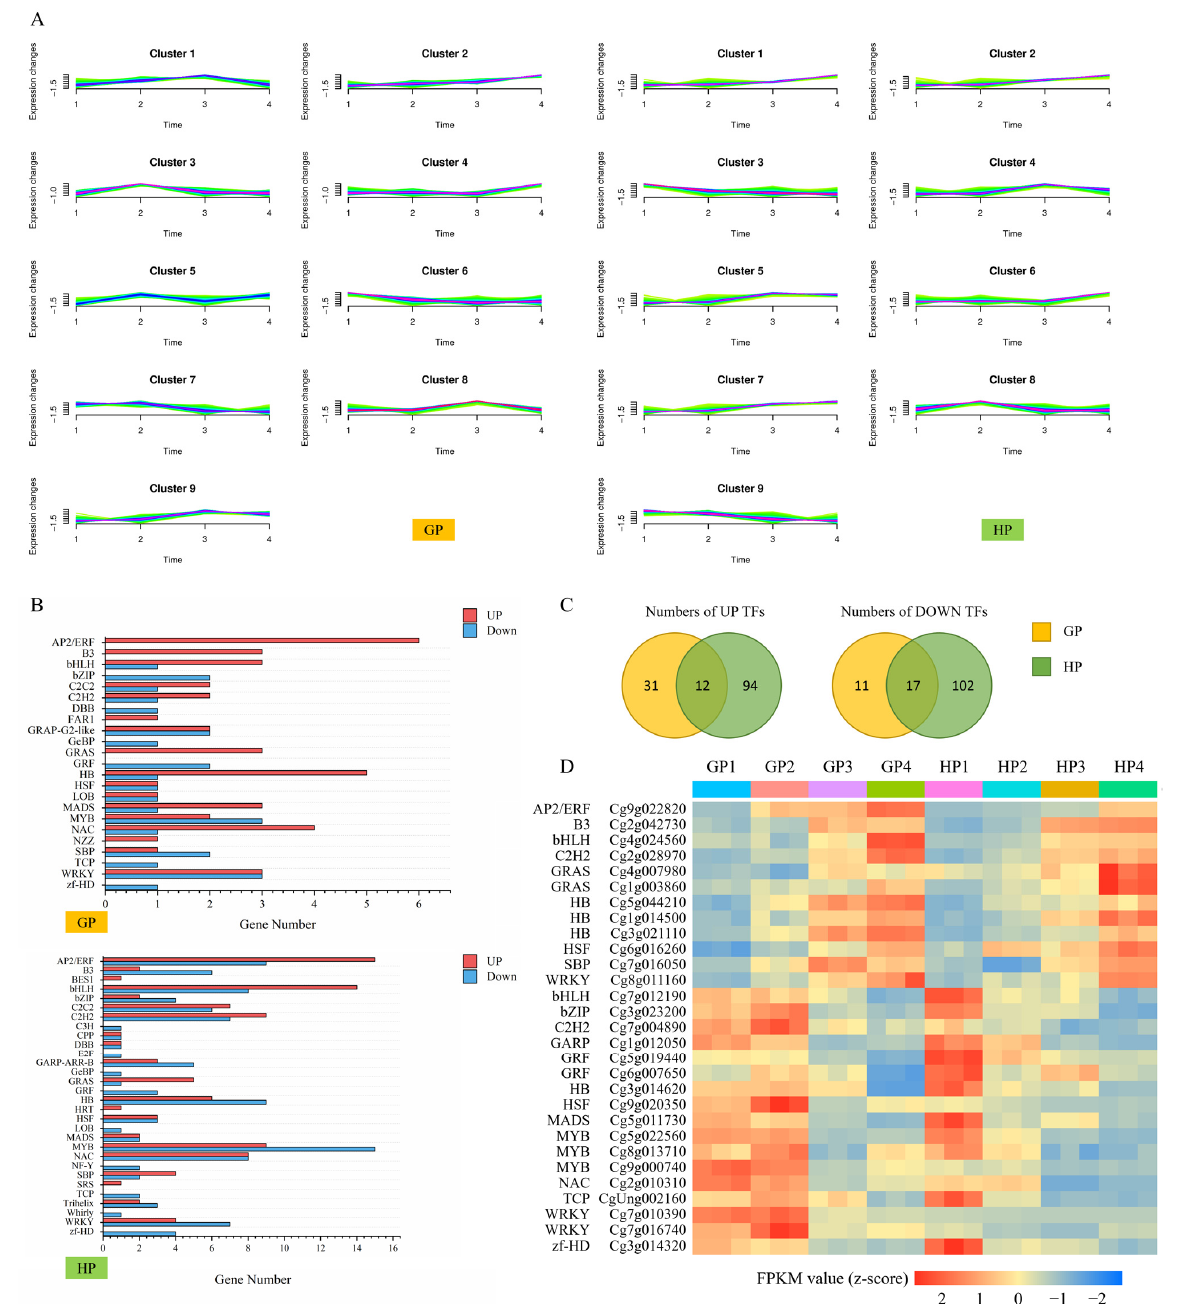
Figure 2. Screening of transcription factors (TFs). ( A ) Time cluster results in two varieties of young pomelo fruits. ( B ) TFs enrichments in specific clusters. In GP, clusters 2 and 7 were separately selected for enriching up- and down-regulated TFs during fruits development; In HP, clusters 1, 2 and 7were selected for enriching up-regulated TFs while clusters 3 and 9 were selected for enriching down-regulated TFs during fruits development. ( C ) Venn plots of the up- and down-regulated TFs in GP and HP varieties. ( D ) The FPKM values of TFs that belonged to the intersection of GP and HP varieties.